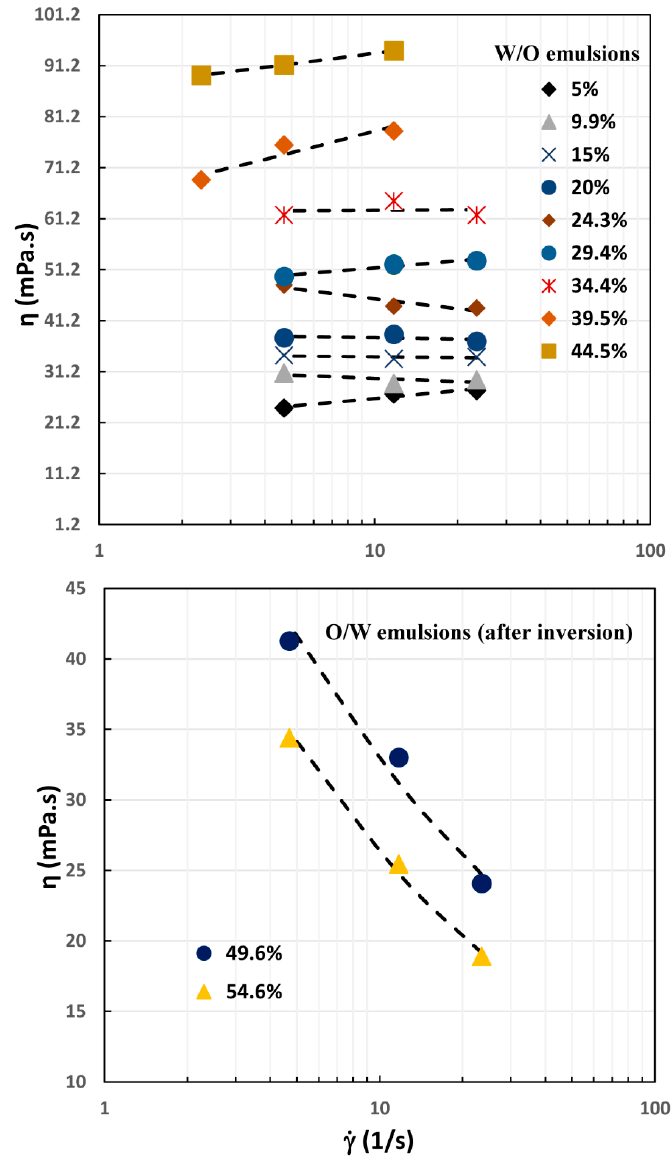
Figure 5. Flow behavior of emulsions with SNP concentration of 0.50% wt. in the aqueous phase. The dashed lines are shown as a guide to the eye. The percent concentrations indicated on the figure are volume percent of aqueous phase.